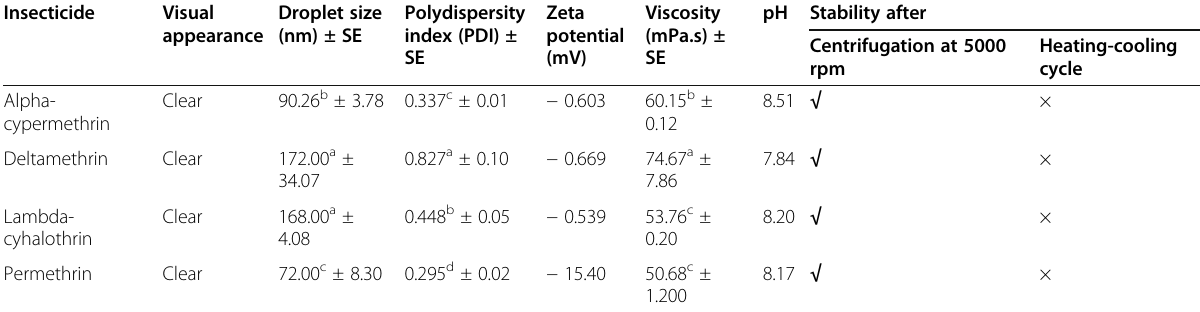
Table 1 The observed visual stability, droplet size, polydispersity index (PDI), zeta potential, dynamic (absolute) viscosity, and pH